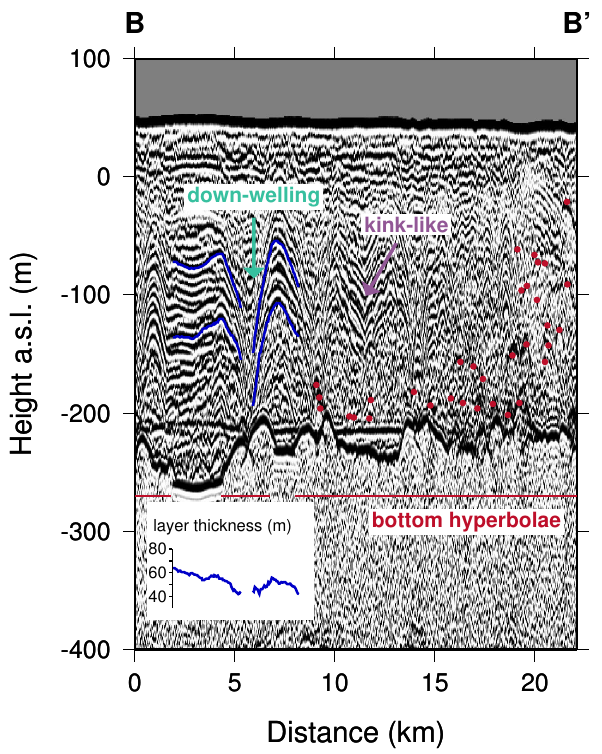
Fig. 3b. Radargram showing a 60 ns profile acquired 2001 rang- ing from B to B 0 (locations of are shown in Fig. 2a). Sections with kink-like (purple) and down-welling (blue) layering are pointed out by arrows. Layer thinning coincident with down-welling is demon- strated by two arbitrarily chosen isochrones, highlighted by blue lines. The layer thickness between these isochrones is shown in the inset. Red dots and line are denoting internal and basal hyperbolae. The horizontal line at an elevation of approximately − 210 m is a multiple reflection between aircraft and